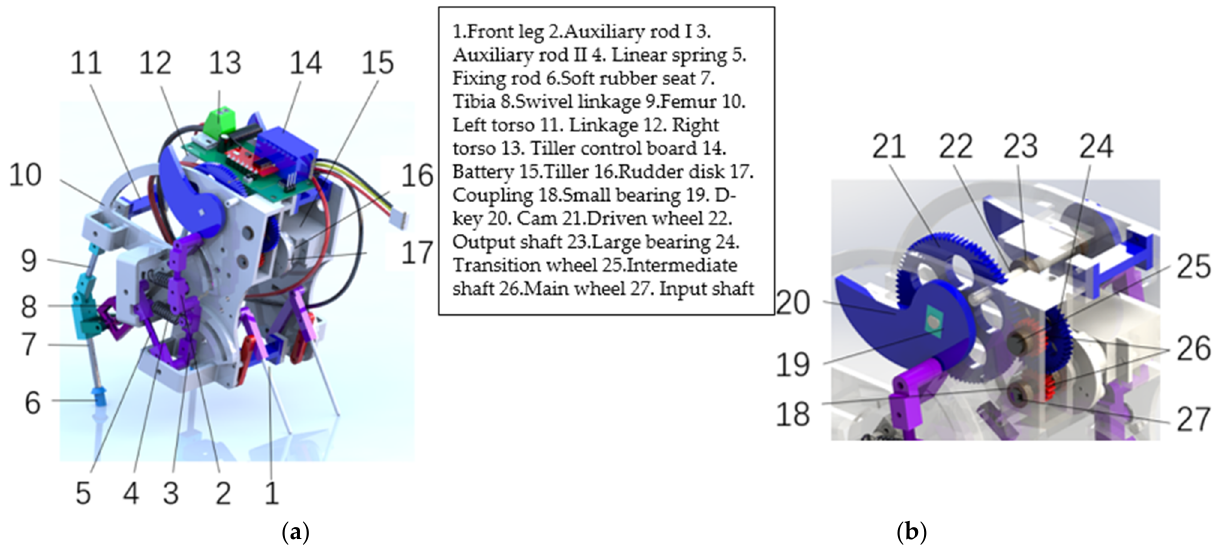
Figure 3. ( a ) Overall structure of the bouncing robot; ( b ) Energy control structures for robots.